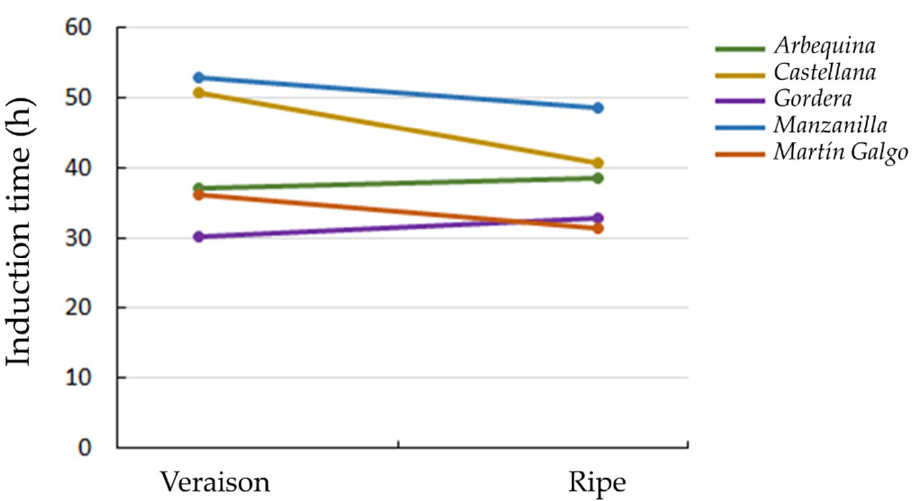
Figure 2. Evolution of the oxidative stability for the virgin olive oils produced with the varieties of olives cultivated in the Aceite de la Alcarria PDO (veraison and ripe). Mean values for the samples collected across the four consecutive olive crop seasons under study.